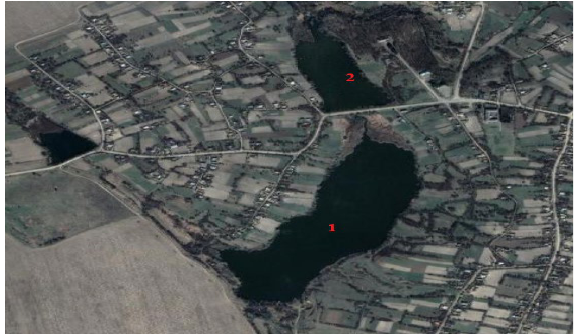
Fig. 1. Artificial reservoirs of the Dobrobut private